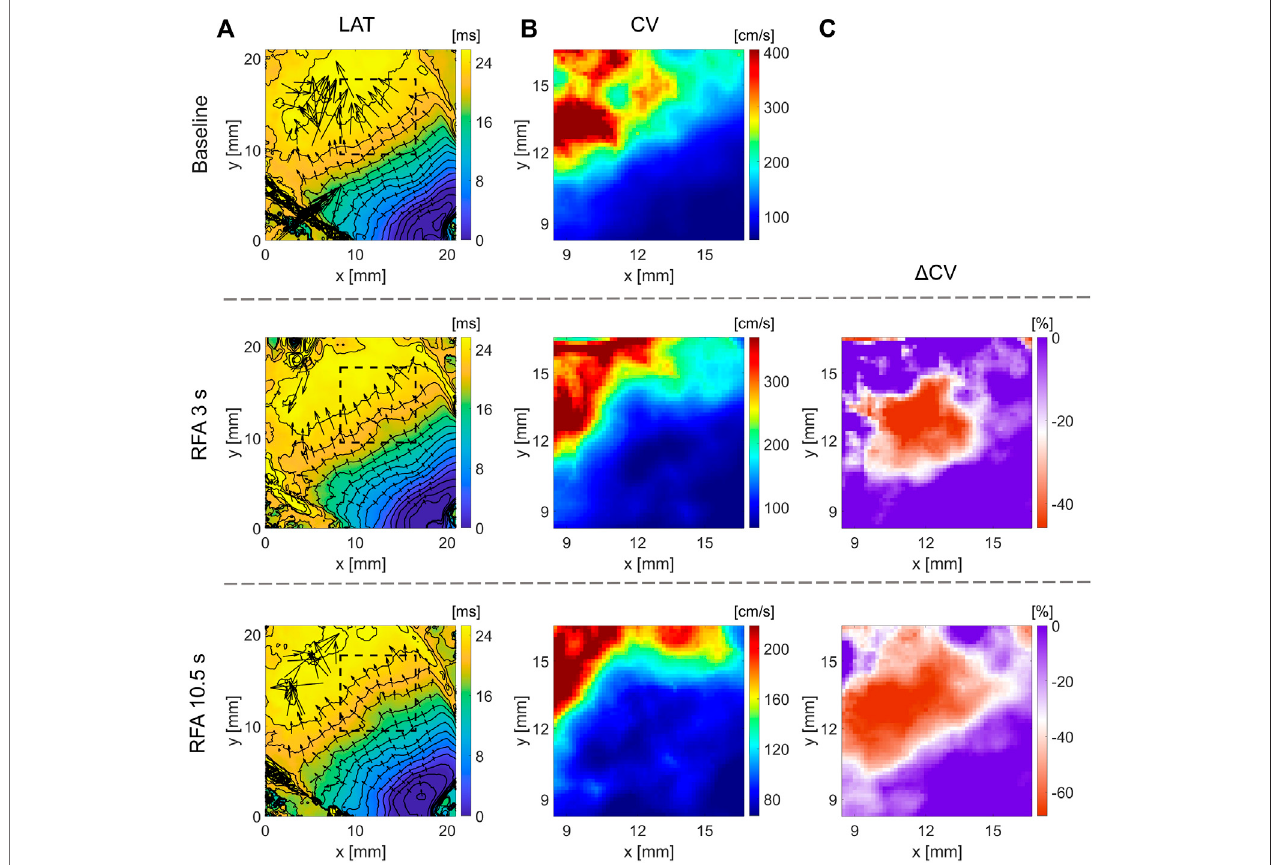
FIGURE 4 | Effect of ablation on CV slowing on guinea pig ventricle for different RFA durations. (A) LAT maps obtained at baseline (top) and RFA duration of 3 s (middle) and 10.5 s(bottom),respectively. (B) RespectiveCV maps inside the dashed square regions, where ablation isperformed,show CV decrease,withalargerCV decreaseafterlongerRFA. (C) RelativedifferenceinCVafterandbeforeablation, Δ CVmaps,outlinestheablatedregionasadistinctdecreaseofCV.Thecolorbarrange inall fi guresissetfromthe5thto95thpercentile,except for Δ CVmaps ’ upperboundarythatwassettozero.Radiusof10pixels(1.6 mm),intheCM,wasusedfor CV